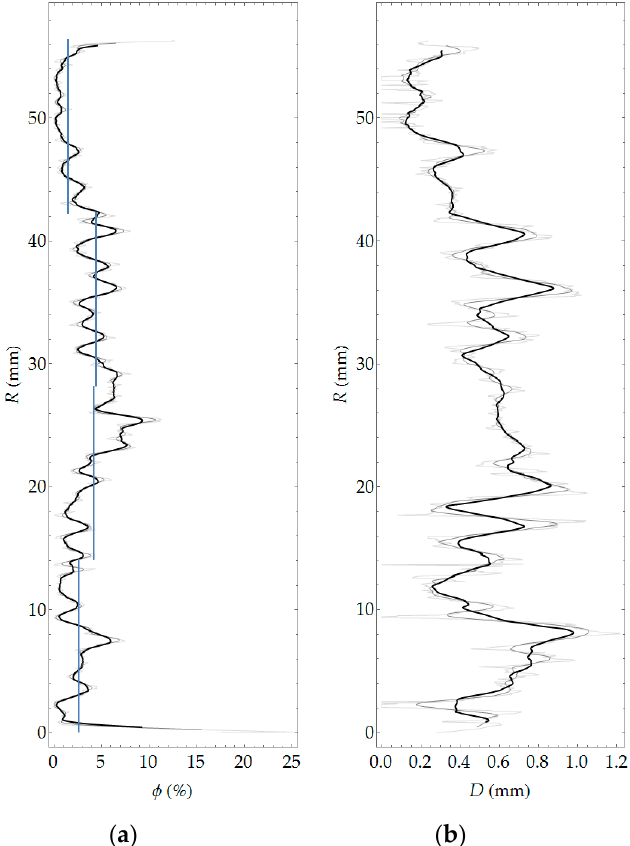
Figure 12. Porosity ( a ) and average local thickness of pores ( b ) as a function of R coordinate.